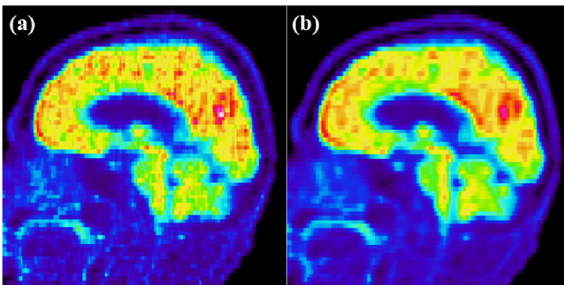
Fig. 10 An example of the sagittal view of a human brain FDG uptake showing the vertical streaking artifacts in the a PSF‑TOFOSEM image and the absence of the artifacts in the b PSF‑HYPR4D‑K‑TOFOSEM image. The streaking artifacts are also visible in the TOF Q.Clear images with low beta values (not